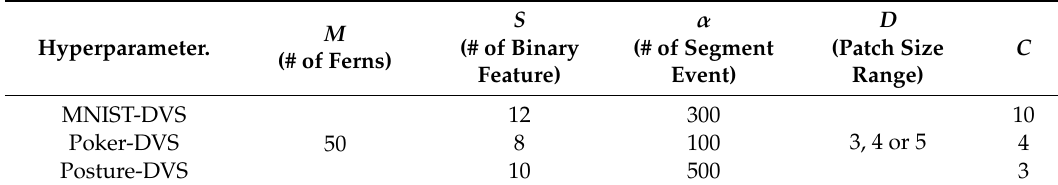
Table 1. Hyperparameter settings for di ff erent DVS datasets [30].